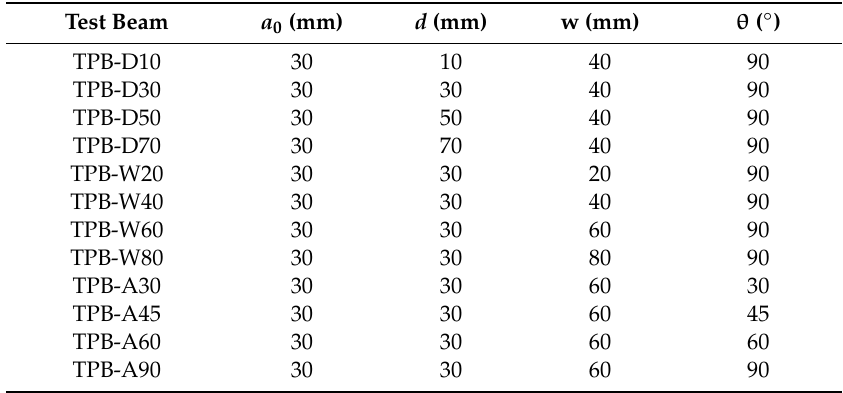
Figure 1. Schematic view of three-point bending (TPB) beam with edge crack and preset crack. Table 1. Dimensions of test beams.